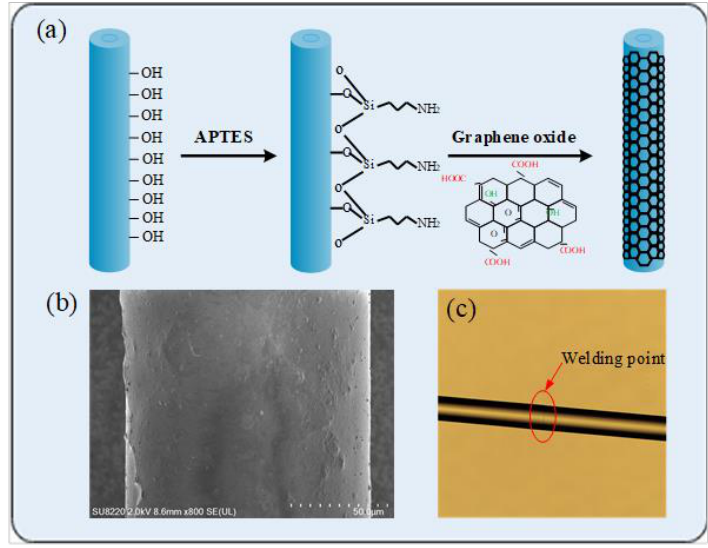
Figure 3. ( a ) Flow chart of GO production. ( b ) SEM figure of GO-coated optical fiber sensor. ( c ) Welding point microscope